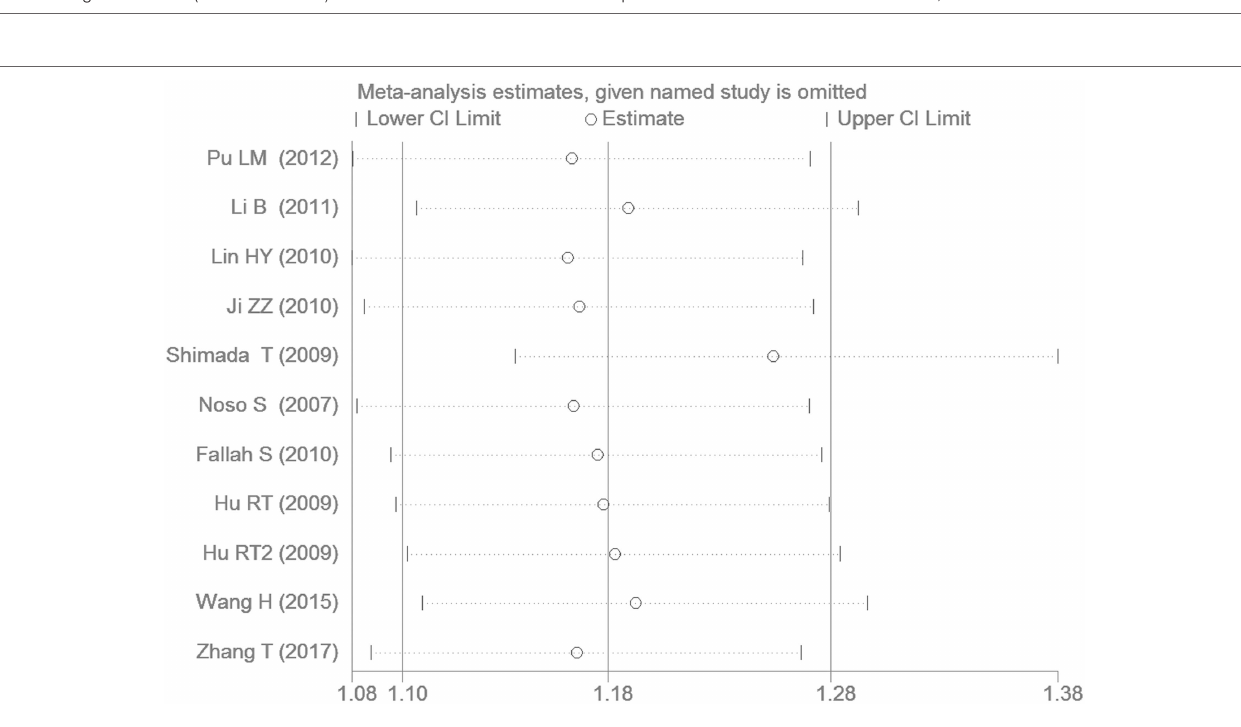
FigUre 8 | Begg’s funnel plot for studies of the association of type 2 diabetes mellitus and small ubiquitin-like modifier 4 gene M55V polymorphism under a recessive genetic model (VV vs. MM + MV). The horizontal and vertical axis correspond to the OR and confidence limits. OR, odds ratio.